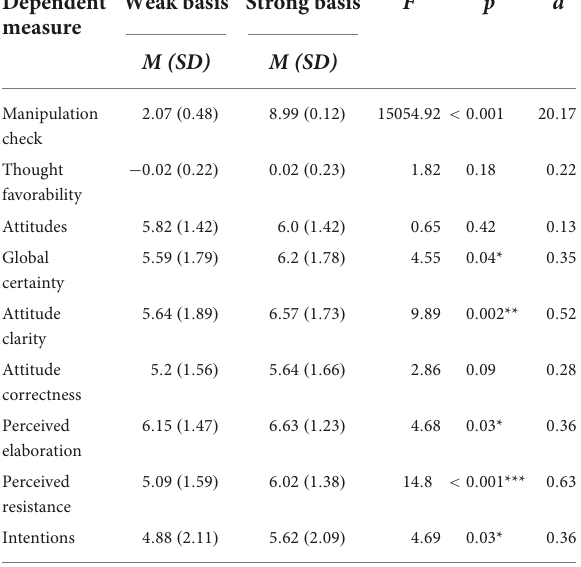
TABLE 2 Study 3 means, standard deviations, and effect sizes for thought favorability, attitudes, attitude clarity, and attitude correctness as a function of the feedback